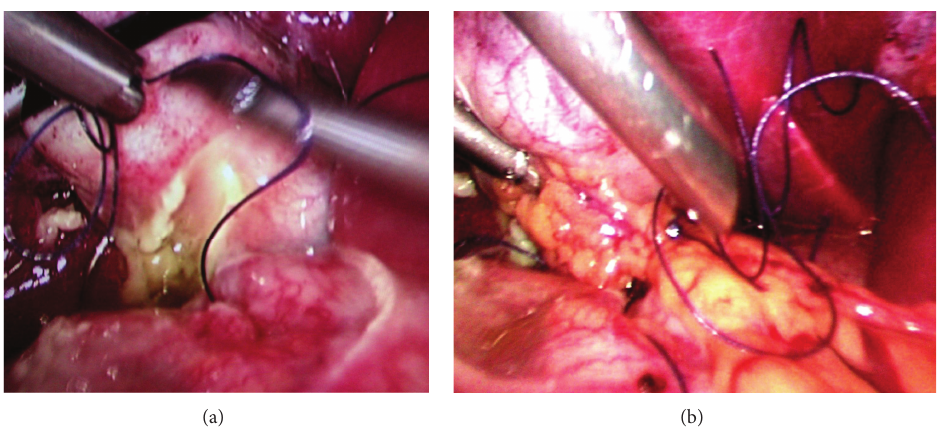
Figure 3: Repair of the large ulcer by primary suture (a) followed by onlay pedicled omentoplasty